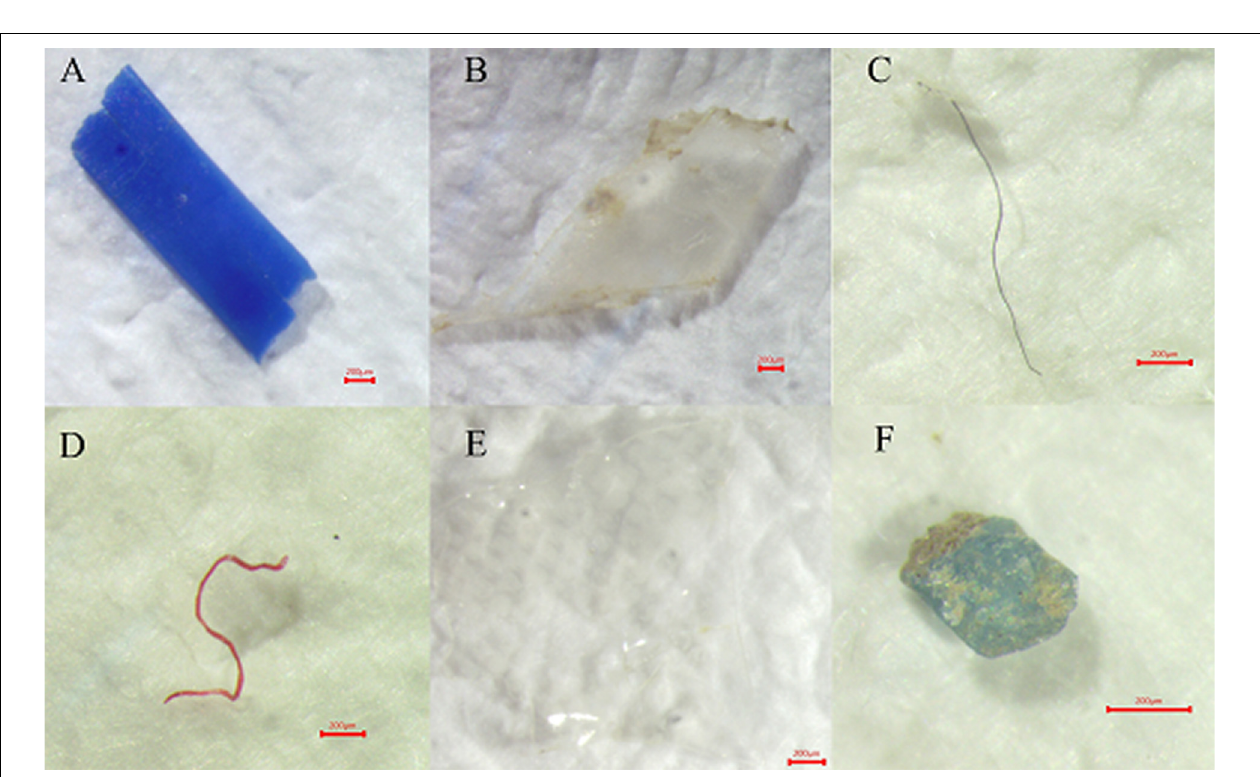
Frontiers in Marine Science |